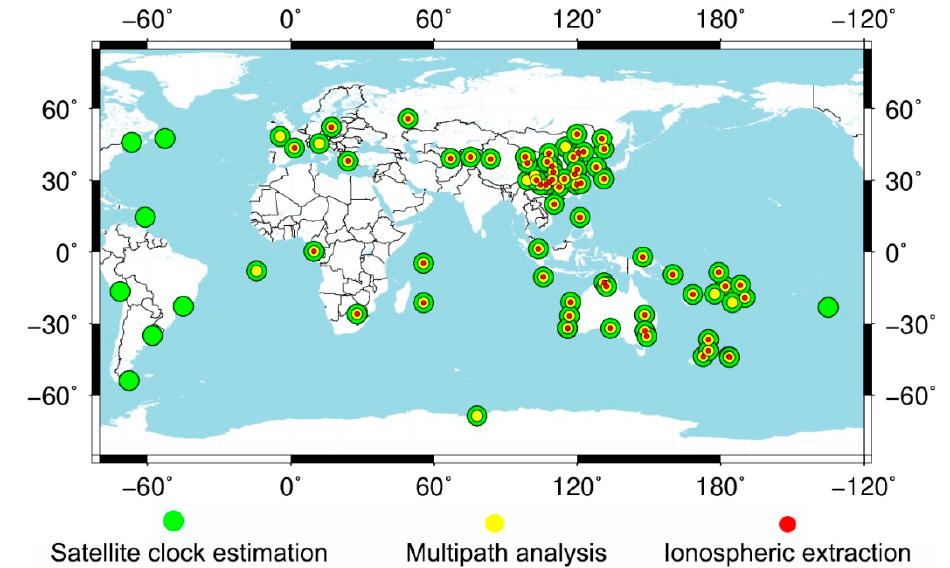
Figure 2. Distribution of the Global Navigation Satellite System (GNSS) stations from the multi-GNSS experiment campaign (MGEX) of the international GNSS service (IGS), and the National BDS Augmentation Service System (NBASS). The points in green, yellow, and red represent the stations used for the satellite clock estimation, multipath analysis, and ionospheric delay extraction, respectively.